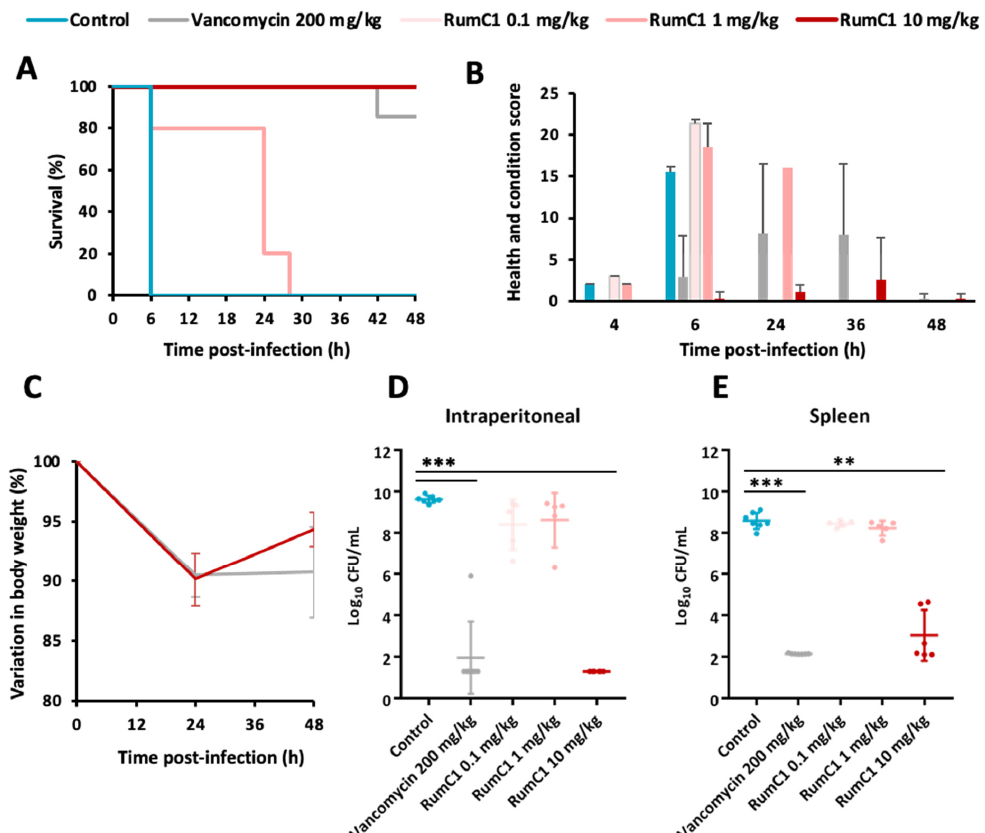
Figure 1. In vivo antibacterial efficacy of RumC1. Mice were challenged intraperitoneally with C. perfringens CP24. After 0.5, 1, and 4 h post-infection (hpi), vancomycin and RumC1 were injected intraperitoneally at 200 mg/kg and 0.1, 1, or 10 mg/kg, respectively, or PBS was injected (control). The groups were composed of five to seven animals. ( A ) The survival of mice was followed over 48 h. The survival of mice that received RumC1 at 0.1 mg/kg does not appear on the figure as their survival had the same evolution as the control mice. ( B ) The health and physical condition of mice was measured over time. High scores are representative of impaired health and physical condition. Criteria measured and observed to determine this score are listed on Figure S2 ( C ). The weight of mice that were still alive at 24 and 48 hpi was measured. ( D , E ) C. perfringens loads found in the intraperitoneal cavity ( D ) or in the spleen ( E ) were measured by plating at the time of death or at the end of the study for the surviving mice (i.e., 48 hpi). Normally distributed data were analyzed using analysis of variance to compare the effects between the different groups, followed by a Bonferroni test to compare the treated groups two by two (** p -value < 0.01, *** p -value < 0.001).